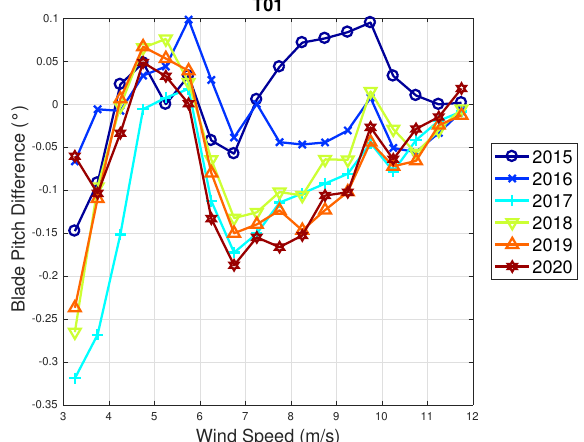
Figure 13. Binned wind speed–blade pitch curve for T01 in WF2: the curves are reported in the form of difference with respect to the year